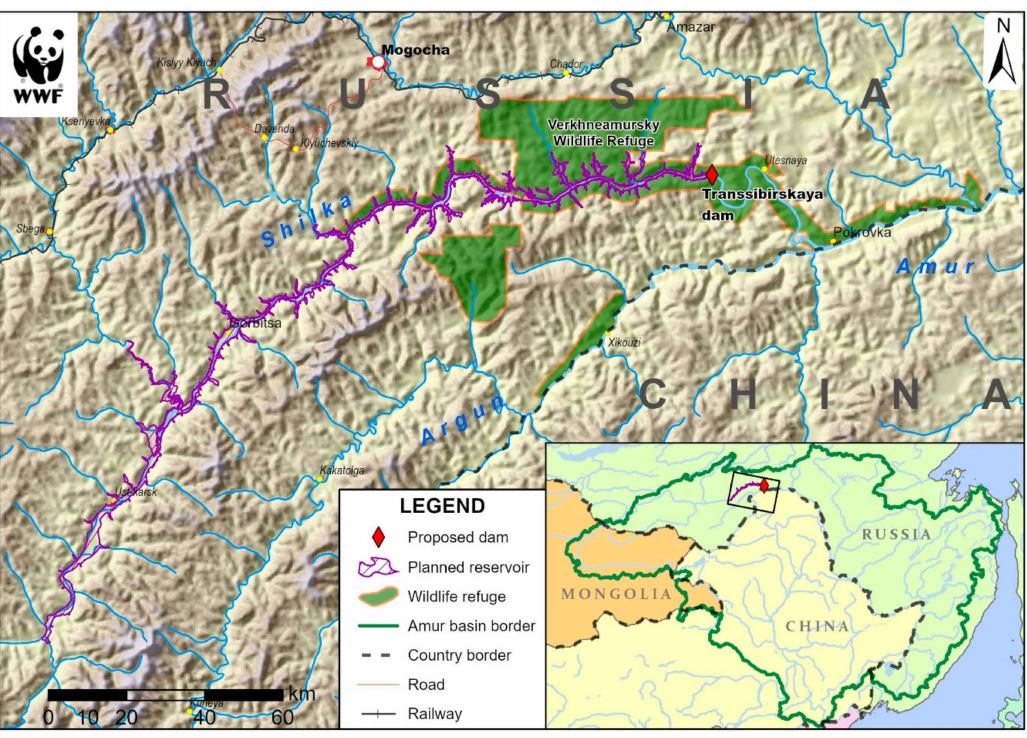
Figure 7. Map of the Verkhneamusky (Upper Amur) Wildlife Refuge and the potential Transsibirskaya dam site. ©